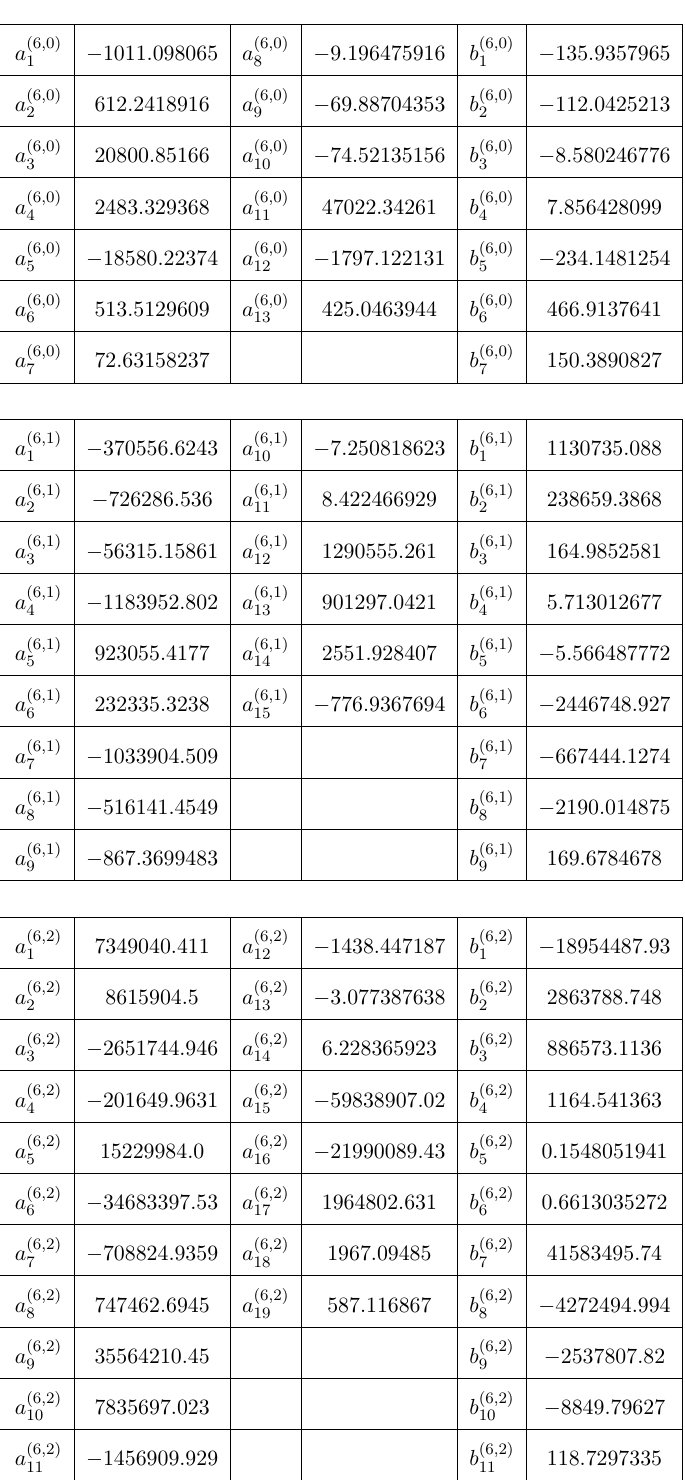
Table 6 . Coe(cid:14)cients of the (cid:12)t functions F (6 ;j ) for j = 0 ; 1 ;